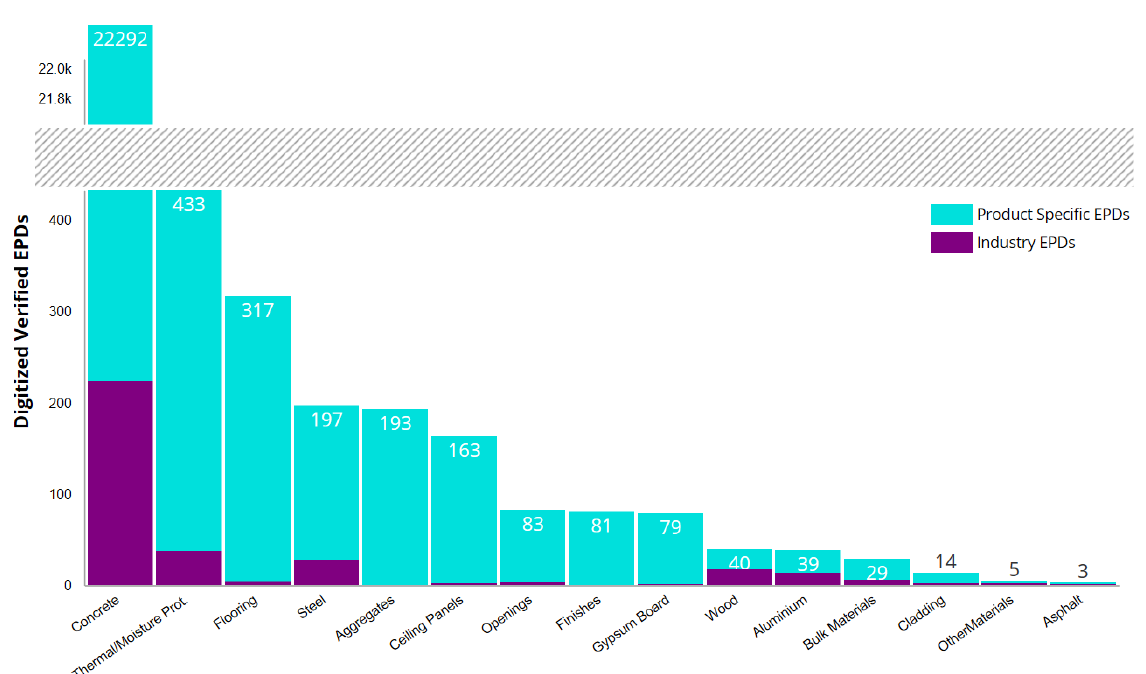
Figure 2. Graph showing number of EPDs for materials in EC3 carbon calculator software